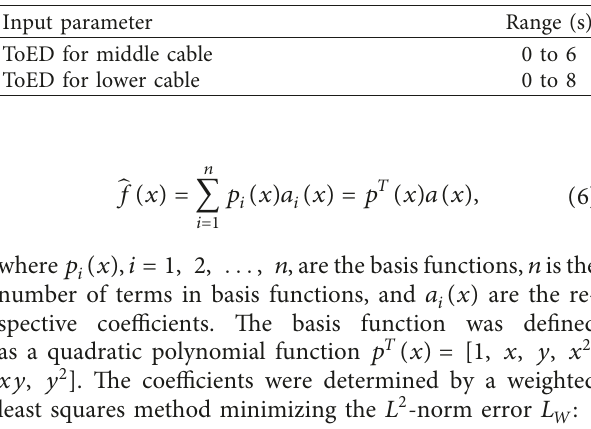
Table 1: Input parameters